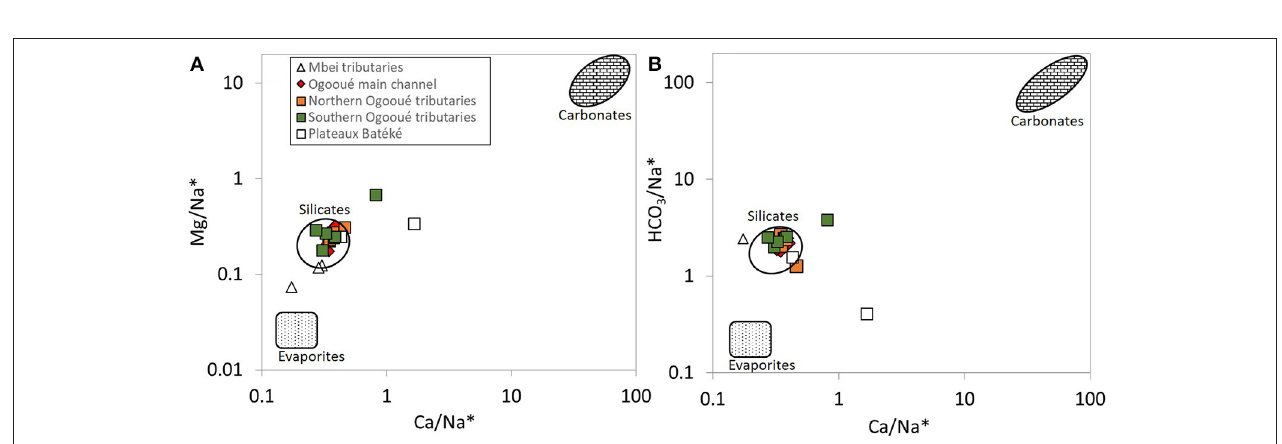
FIGURE 6 | Mixing diagrams indicating the source of solutes to the rivers of the Ogooué and Mbei basins (A) Mg/Na* vs. Ca/Na* and (B) HCO 3 /Na* vs. Ca/Na*. The “*” symbol stands for concentrations corrected from atmospheric inputs (Equation 2). The silicate, carbonate and evaporite end members defined by Gaillardet et al., 1999b are shown for